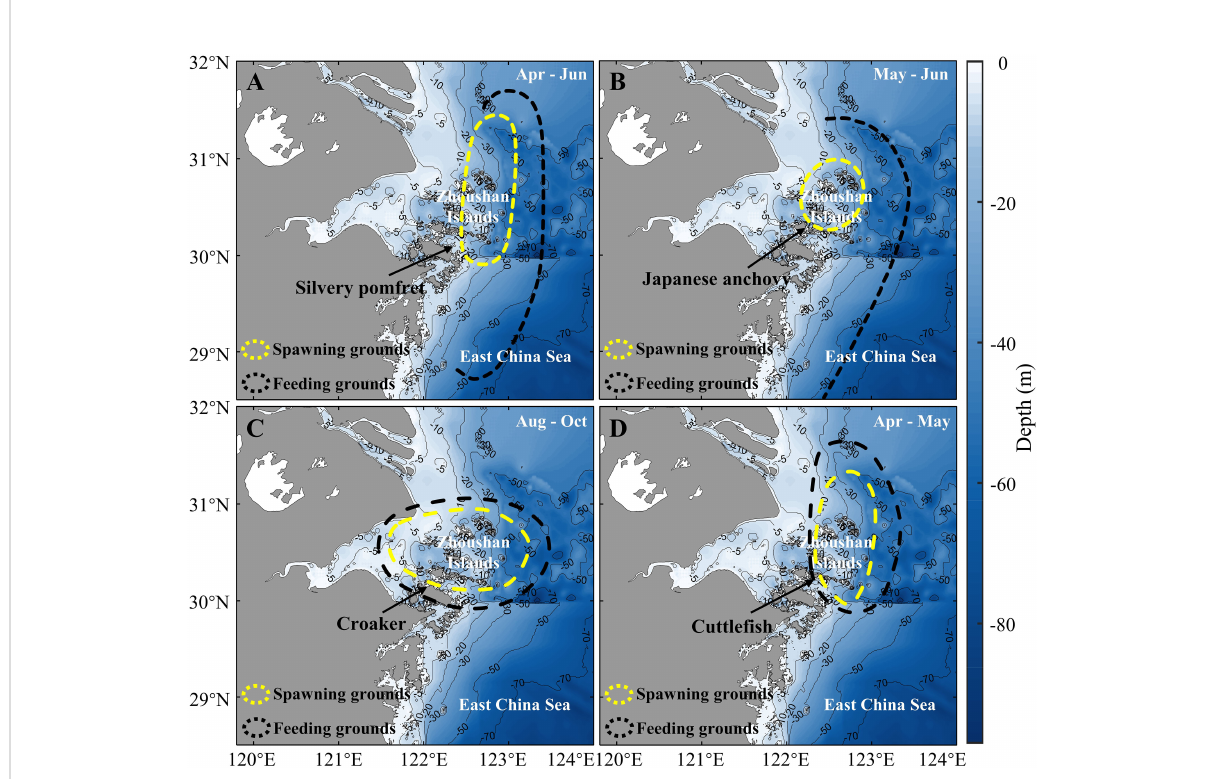
FIGURE 7 Spawning grounds and feeding grounds for various fi sh species in the Zhoushan Archipelago Sea area. (A) Silver pomfret; (B) Japanese anchovy; (C) Croaker; (D) Cuttle fi sh. Yellow circles: spawning grounds; black circles: feeding